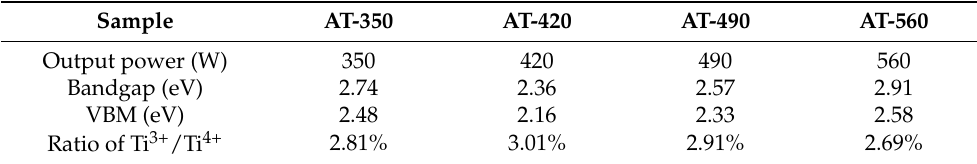
Figure 5. The bandgap structures of all samples.